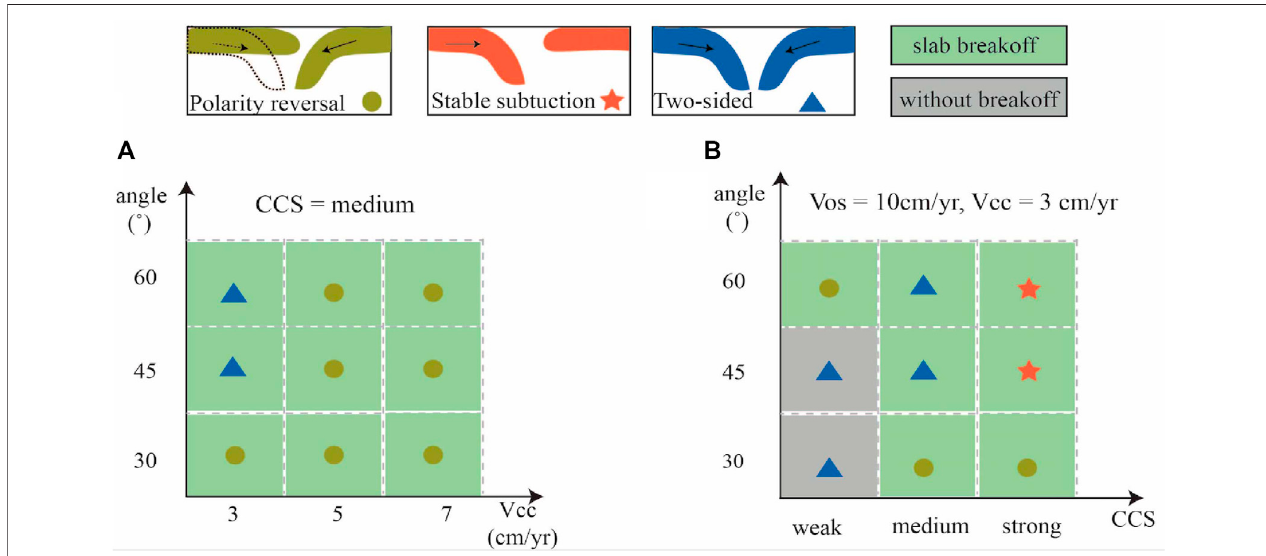
FIGURE 8 | Schematic fi gures of continental collision modes depending on (A) subducting angle and plate velocity, and (B) subducting angle and crustal rheological strength. Different symbols denote different collision modes.